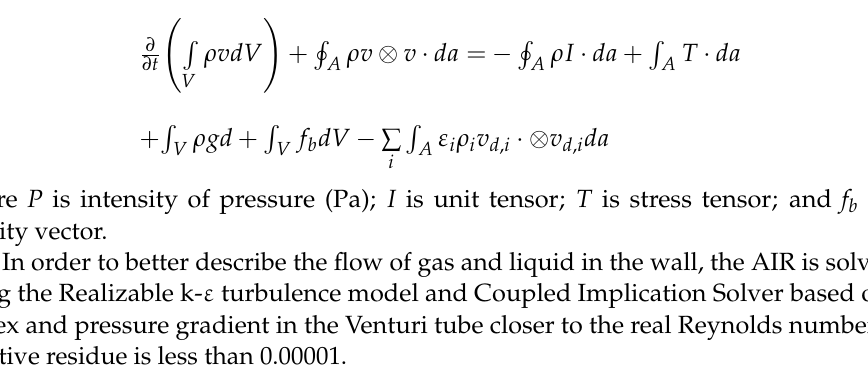
Table 1. Grid independence test.